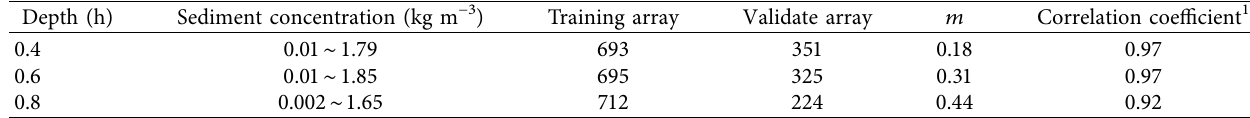
Table 1: Regression results of the vertical time-averaged velocity coefcient m .